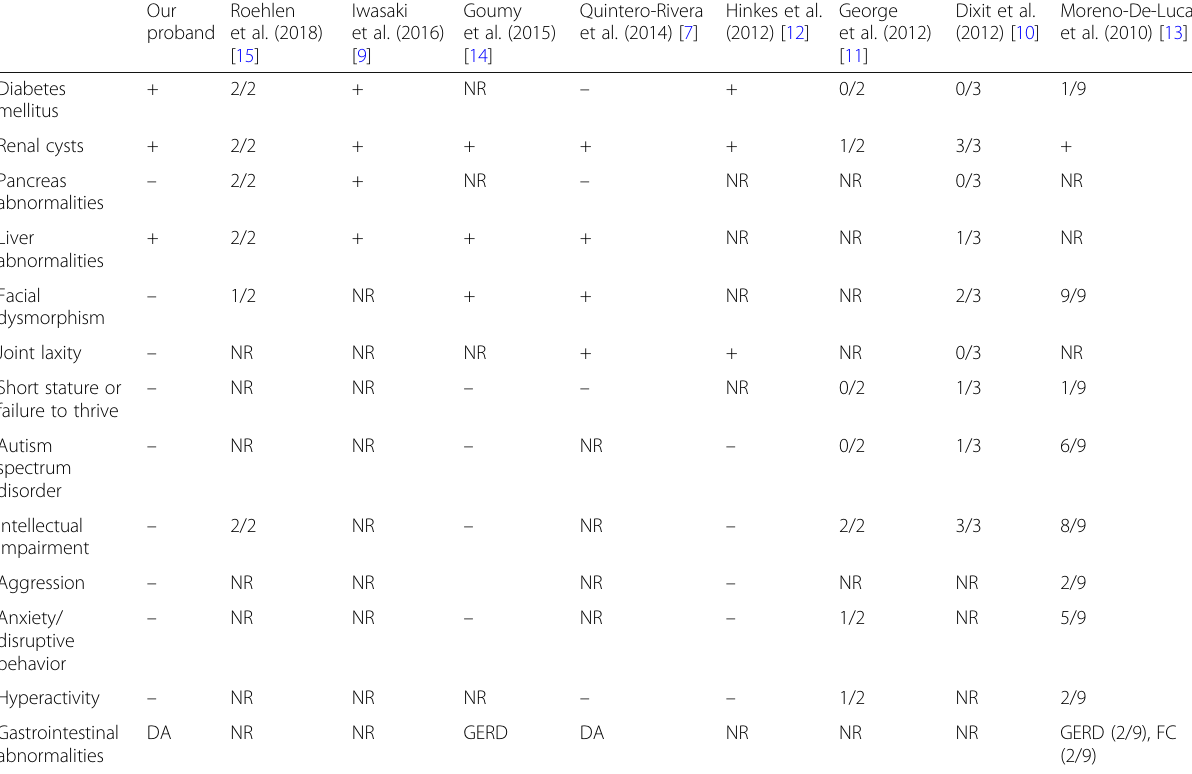
Table 1 Comparisons of clinical manifestations in our proband and previously reported patients with a similar phenotype or deletion region in Chr17q12 Our Roehlen proband et al. (2018) Diabetes